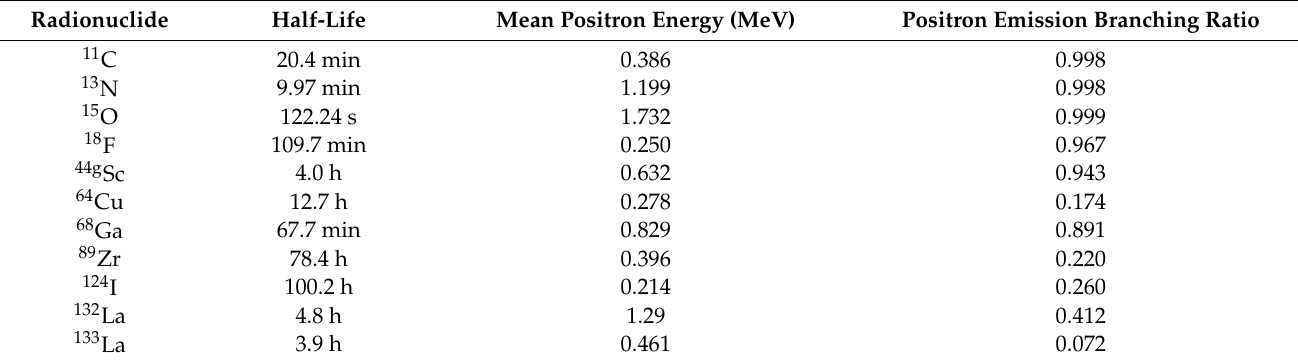
Table 1. Typical positron emitters, half-lives, and mean positron energies [13].